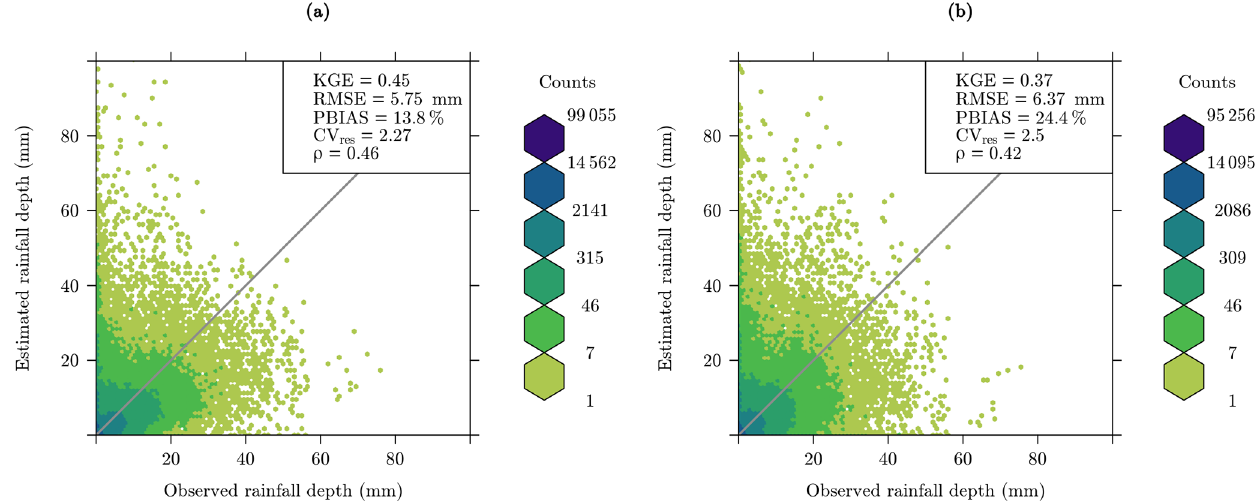
Figure 5. Daily path-averaged rainfall depth comparison of CML rainfall estimates against gauge-adjusted radar data: (a) rainfall retrieved using calibrated parameters; (b) rainfall retrieved using default parameters. Table 5. The 15min path-averaged rainfall depth performance for different thresholds. Note: reference is provided by the gauge-adjusted radar data. Thresholds of RAINLINK with KGE RMSE PBIAS CV res ρ rainfall (mm) parameters (mm) (%) Reference OR Default 0.21 RAINLINK > 0 Calibrated 0.27 Reference OR Default Reference OR